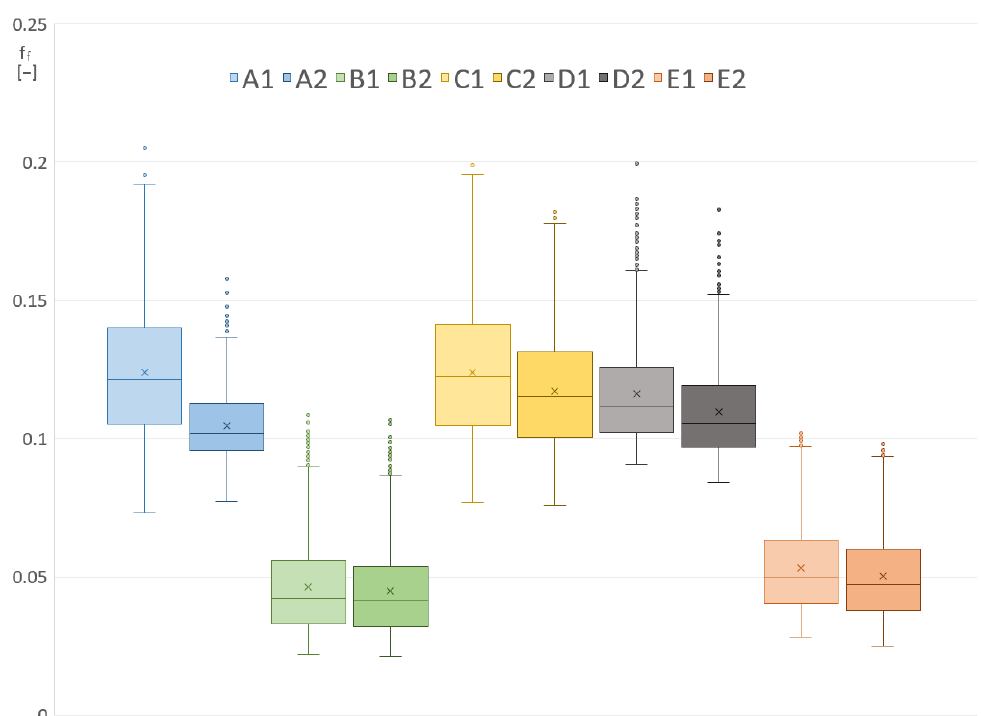
Figure 5. Statistical distribution of the f f values in all possible robot locations for the ten testing trajec- tories (standard box-plot diagram—each box is bounded by the first and third quartile, the horizontal line represents the median, the × represents the arithmetic mean, and circles represent